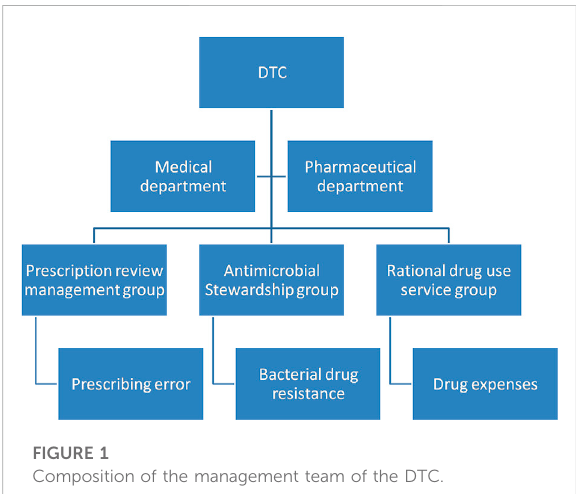
FIGURE 1 Composition of the management team of the